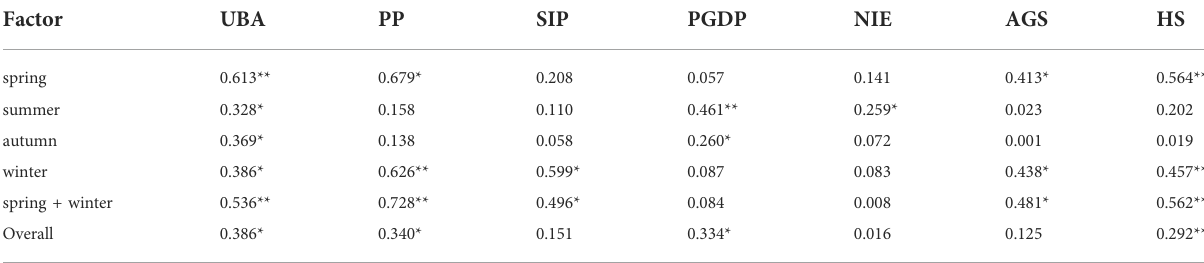
TABLE 4 Explanation degree of different social factors to PM2.5 concentration changes. Factor